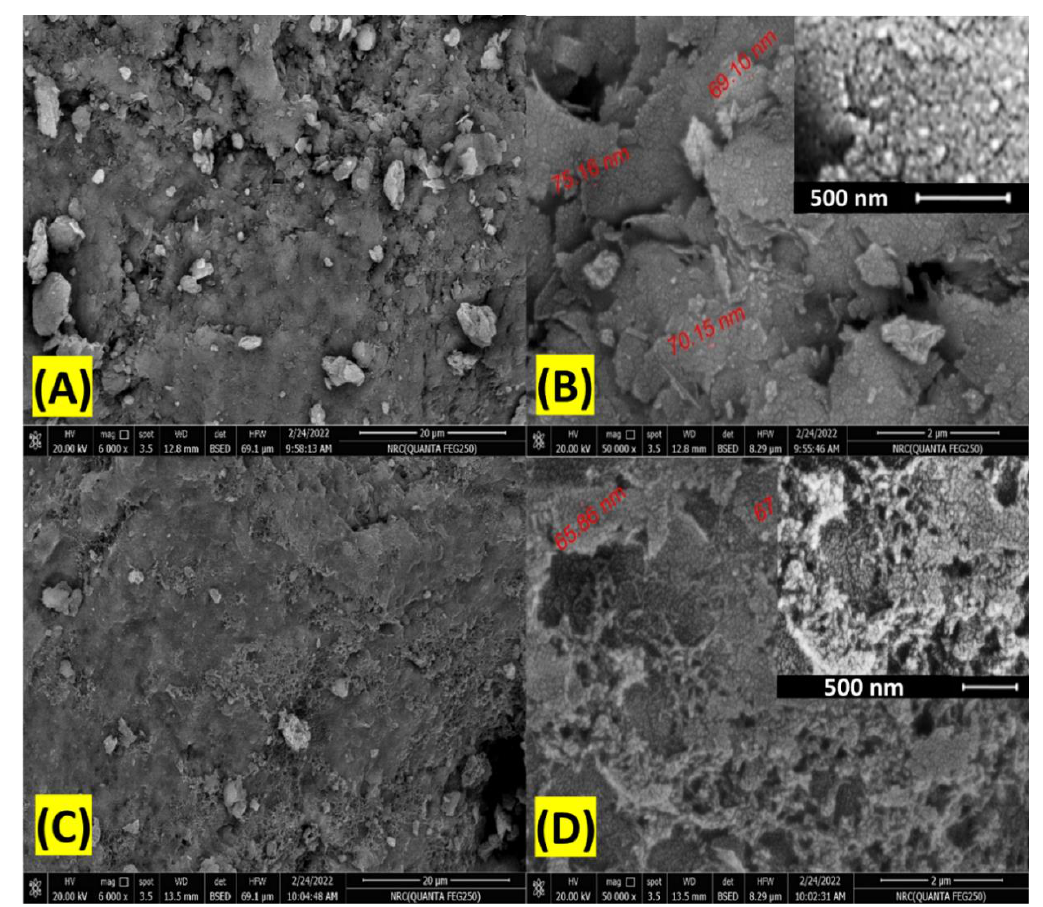
Figure 2. SEM micrograph for ( A , B ) Gl and ( C , D ) Gl/PAN nanocomposite.